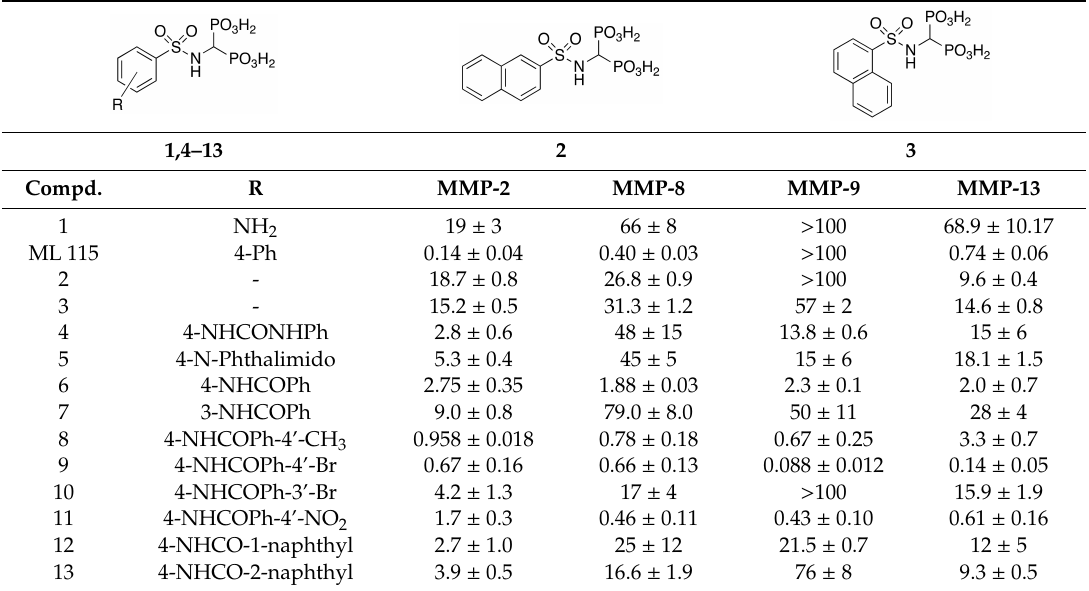
Table 1. Inhibition data for compounds 1–13 against matrix metalloproteinases